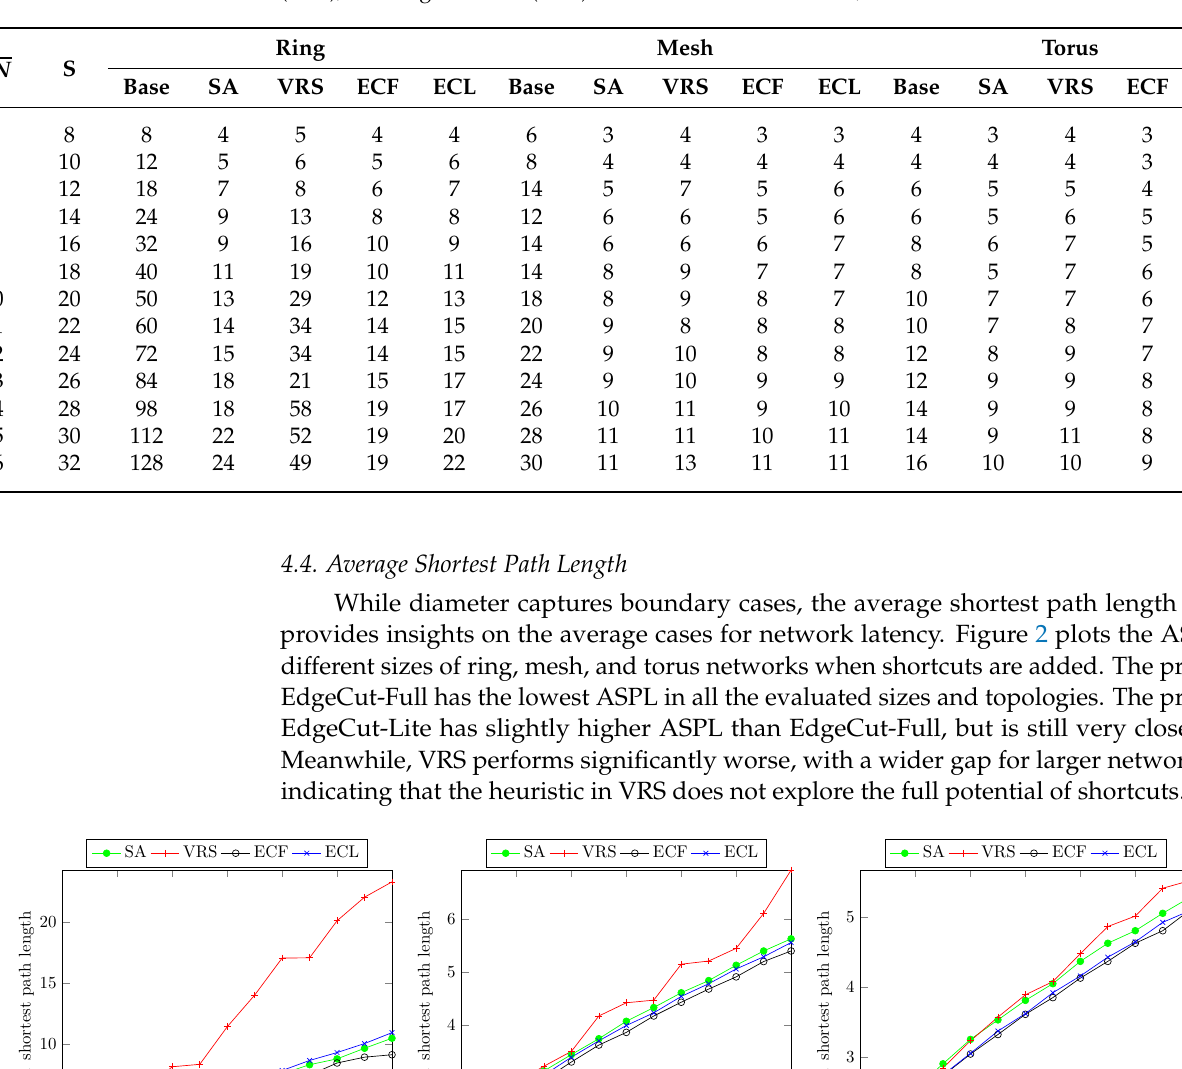
Table 2. Diameter for simulated annealing (SA), vertex-based random shortcut (VRS), EdgeCut-Full (ECF), and EdgeCut-Lite (ECL). “S” denotes shortcut limit, and “Base” denotes base diameter.